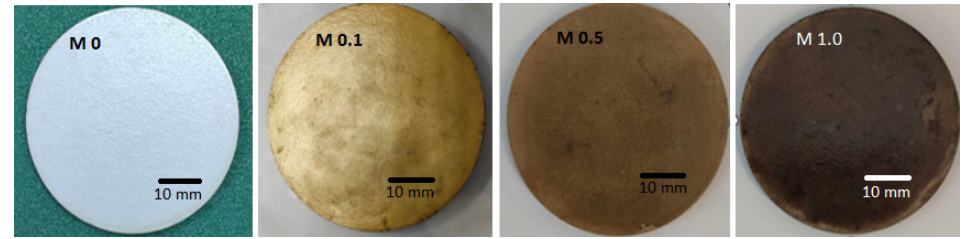
Figure 3 . Optical images of pristine and Ag-CuO-coated membranes . Figure 3. Optical images of pristine and Ag-CuO-coated